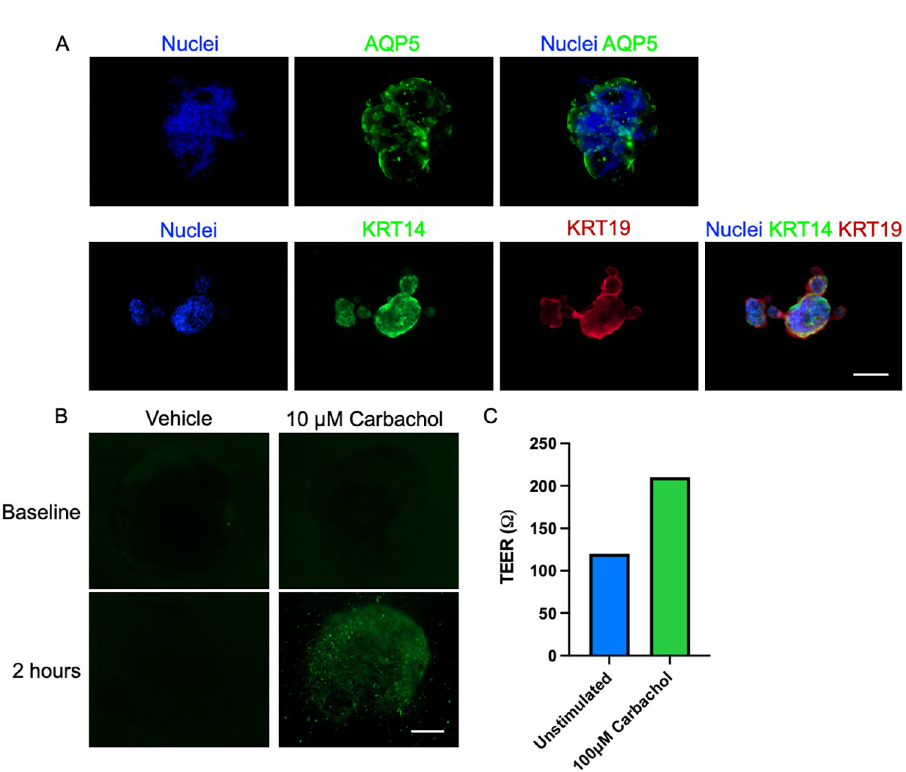
Fig 5. Epithelial compartments and representation of functional datasets in LG organoids. Expression of acinar, ductal and progenitor epithelial markers (A). Epithelial function evaluated by Ca 2+ uptake assays after parasympathetic stimulation with carbachol (B) and trans-epithelial electrical resistance (TEER) (C) in LG organoids. Scale bar: 200 μ m. https://doi.org/10.1371/journal.pone.0272644.g005 PLOS ONE | https://doi.org/10.1371/journal.pone.0272644 August 5,